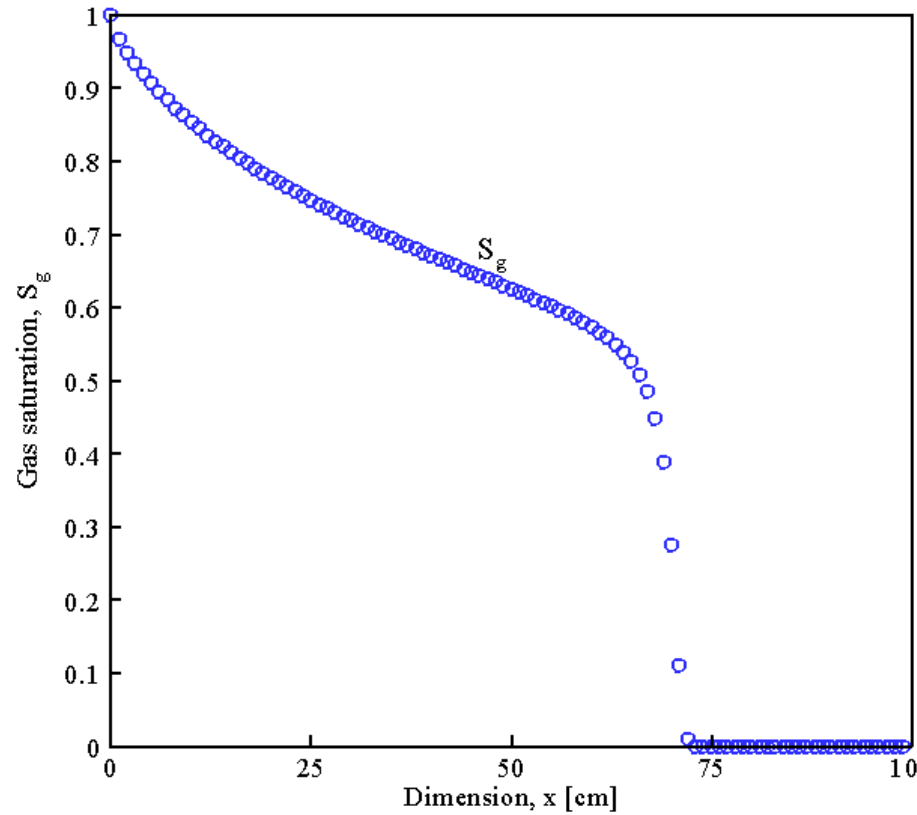
Figure 4. Gas saturation S g versus dimension x at the different thermobaric conditions in the computational domain.